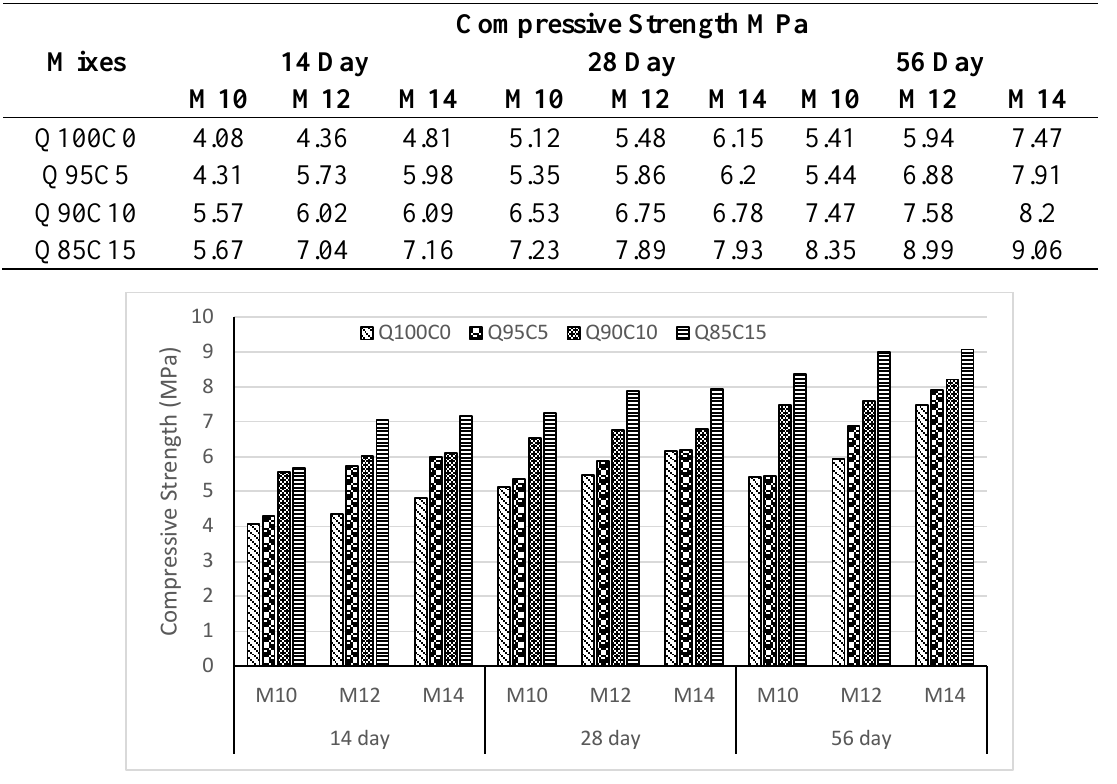
Fig. 6. Effect of OPC replacement and NaOH concentration variation on compressive strength of quartz stone powder- based